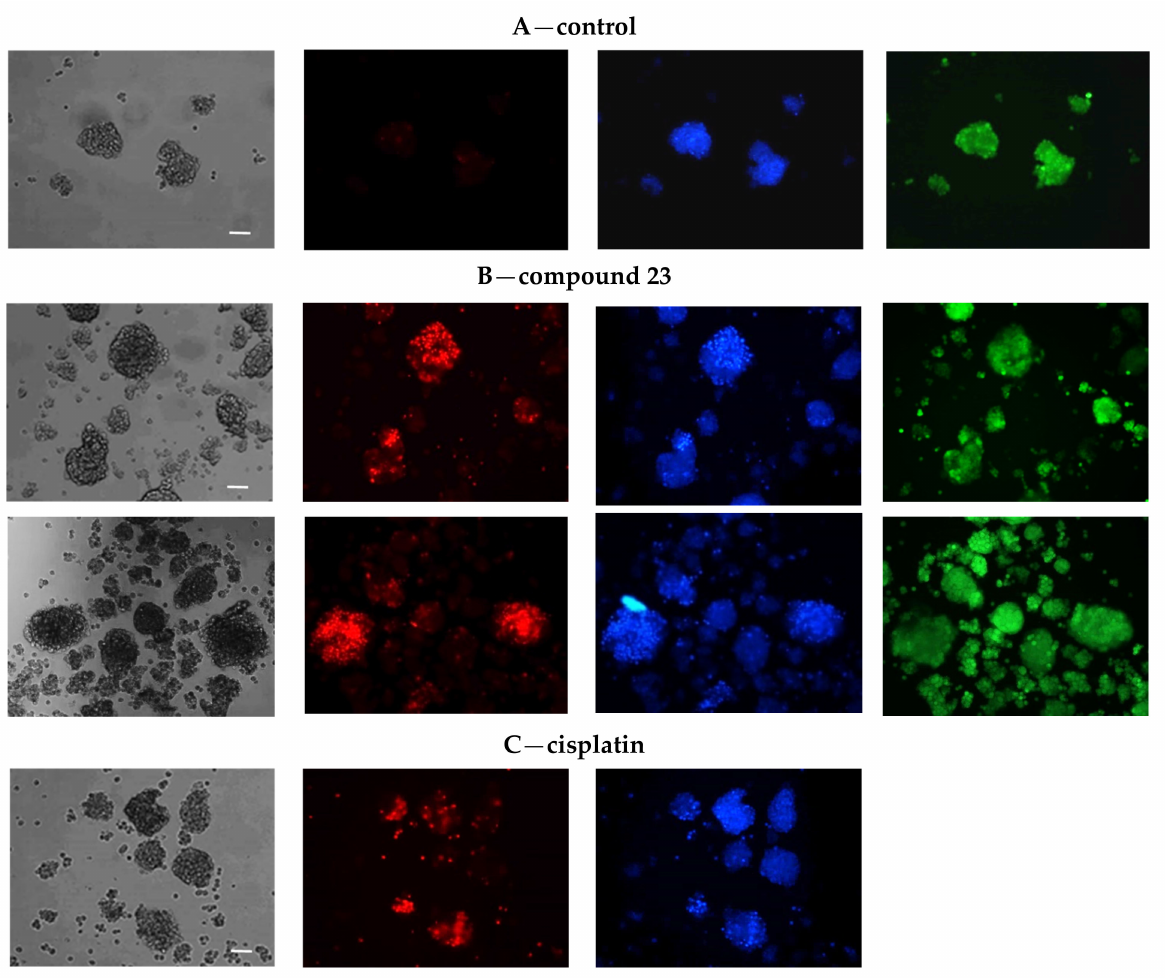
Figure 11. Microphotographs of A2780 spheroids ( A ) control, ( B ) treated with compound 23 , and ( C ) cisplatin. The spheroids were cultured for 48 h with compound 23 (40 µ M), cisplatin (10 µ M), or untreated. Next, the cells were transferred to 8-chamber slides and then stained with PI (red, dead cells), Hoechst 33258 (blue fluorescence, nuclei), and additionally with CellTrackerGreen (green fluorescence, cytoplasm, A , B ), as described in the Section 4. Spheroids were photographed under an epifluorescence microscope Nikon Eclipse TE2000-U equipped with digital color camera (10 × PlanFluor objective, scale bar 50 µ m, focus on dead PI-stained cells). Contrast images of A2780 spheroid morphology were captured using the differential interference contrast (DIC, Nomarski) focusing on spheroid boundary (the method of imaging is described in Supplementary Materials, Figure S11). At least 6–10 fields were collected per slide. Three separate experiments were carried out. Representative microphotographs are presented. In all photographs of PI (red) stained cells ( A – C ), the image brightness was equally increased by 20% for better visibility of dead cells in the control ( A